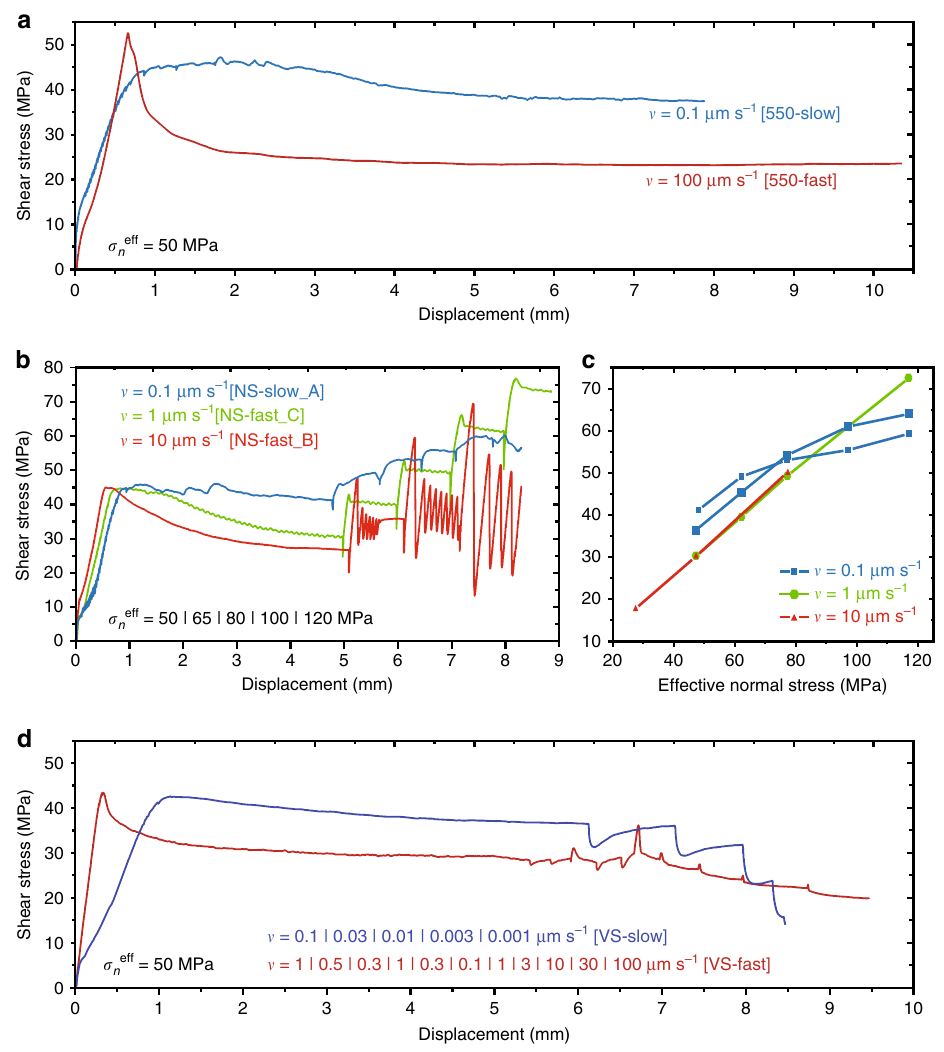
Fig. 1 Hydrothermal shear tests on layers of simulated calcite fault gouge at 550 °C. a Experiments performed at a constant effective normal stress ( σ n eff ) of 50 MPa, using a sliding velocity ( v ) of 0.1 and 100 μ m s − 1 . b Effective normal stress-stepping experiments. c Steady-state shear stress plotted against effective normal stress, taken from experiments performed using v = 0.1 μ m s − 1 (NS-slow_A and NS-slow_B) and ≥ 1 μ m s − 1 (NS-fast_A and NS-fast_C). d Velocity-stepping experiments. Supplementary Tables 1 – 3 list all experiments and strength